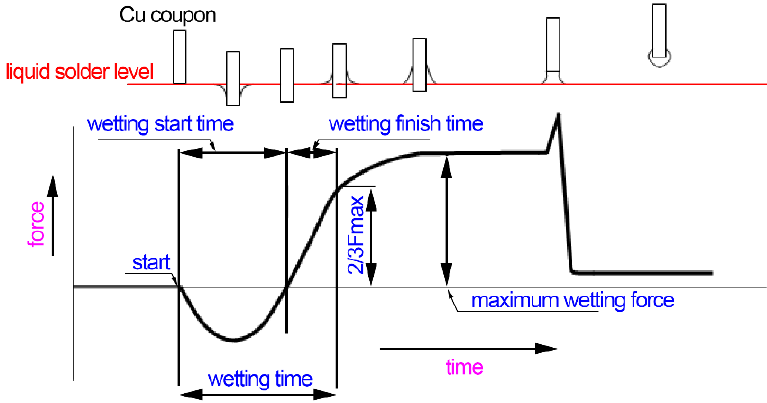
Figure 1. Schematic diagram of a typical wetting curve reflects the function between force and time.